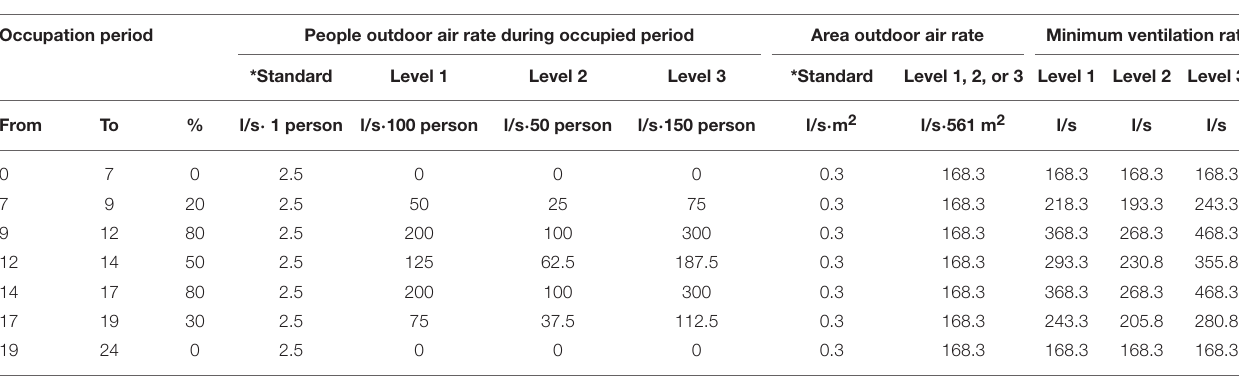
TABLE 3 | Minimum ventilation